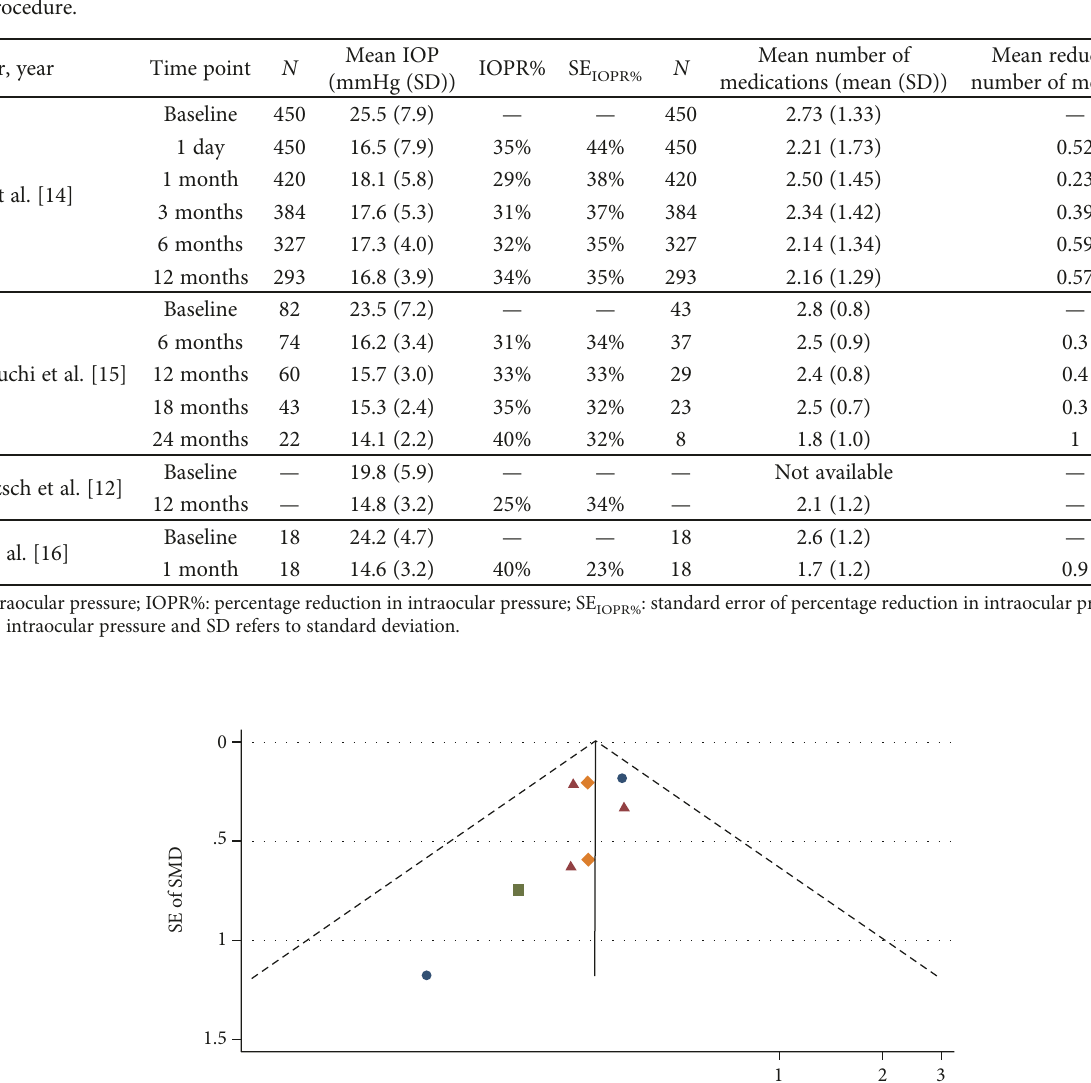
Table 1: Reported pre- and postoperative IOP and number of glaucoma medications for POAG cases undergoing Trabectome as a solo procedure.